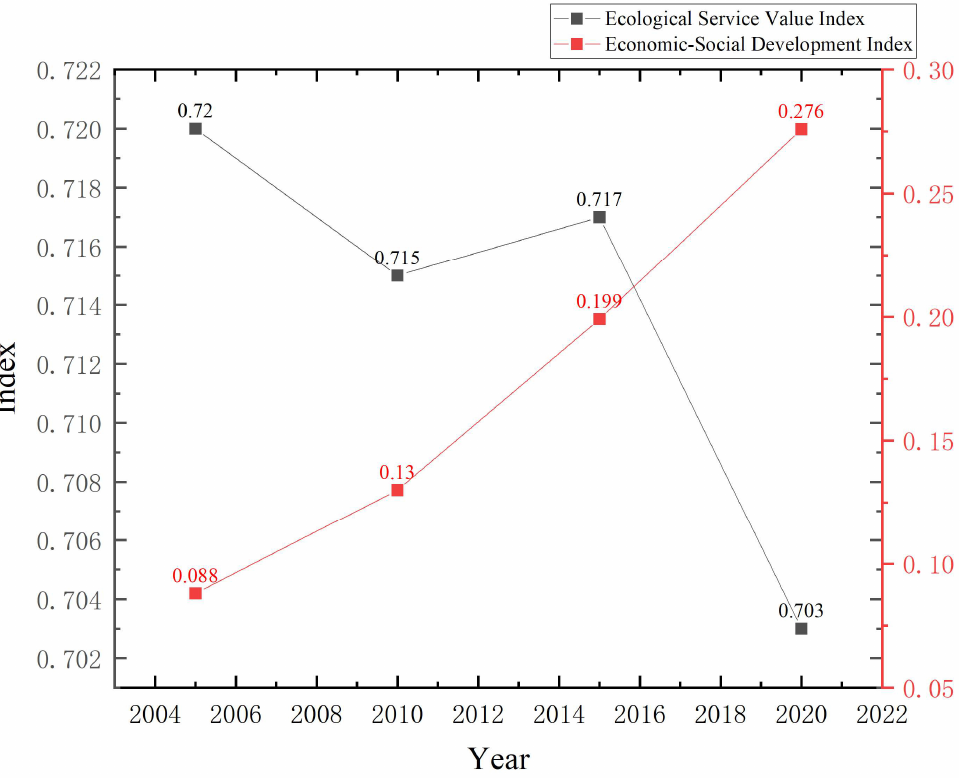
Figure 4. Time series of land ecosystem services and economic–social development indices in CCCG.